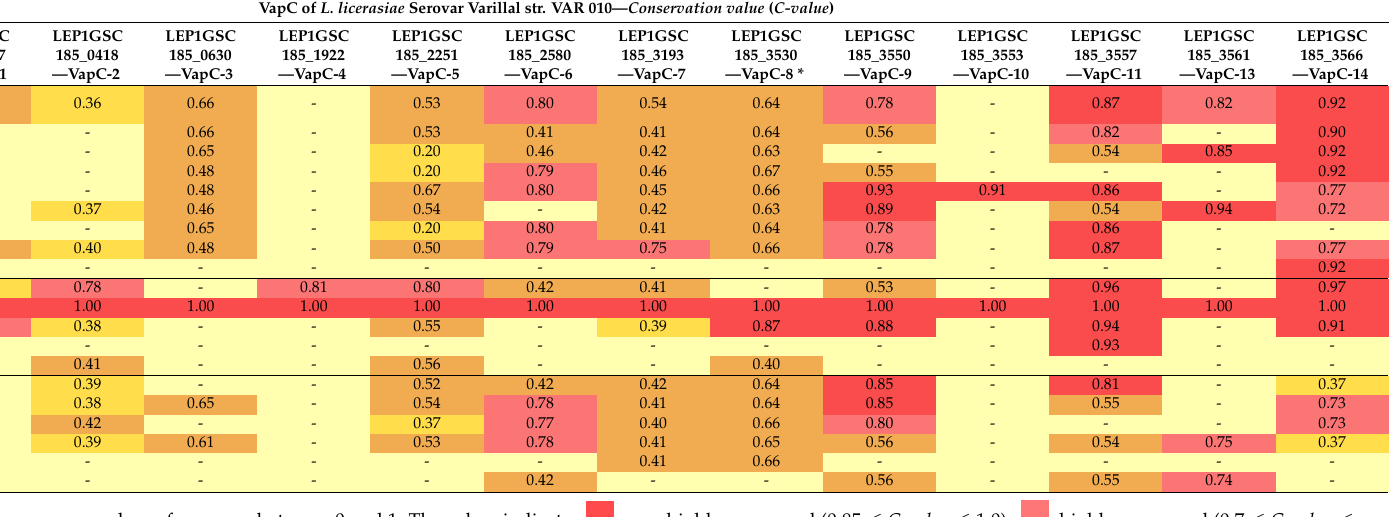
very highly conserved (0.85 ≤ C-value ≤ 1.0); highly conserved (0.7 ≤